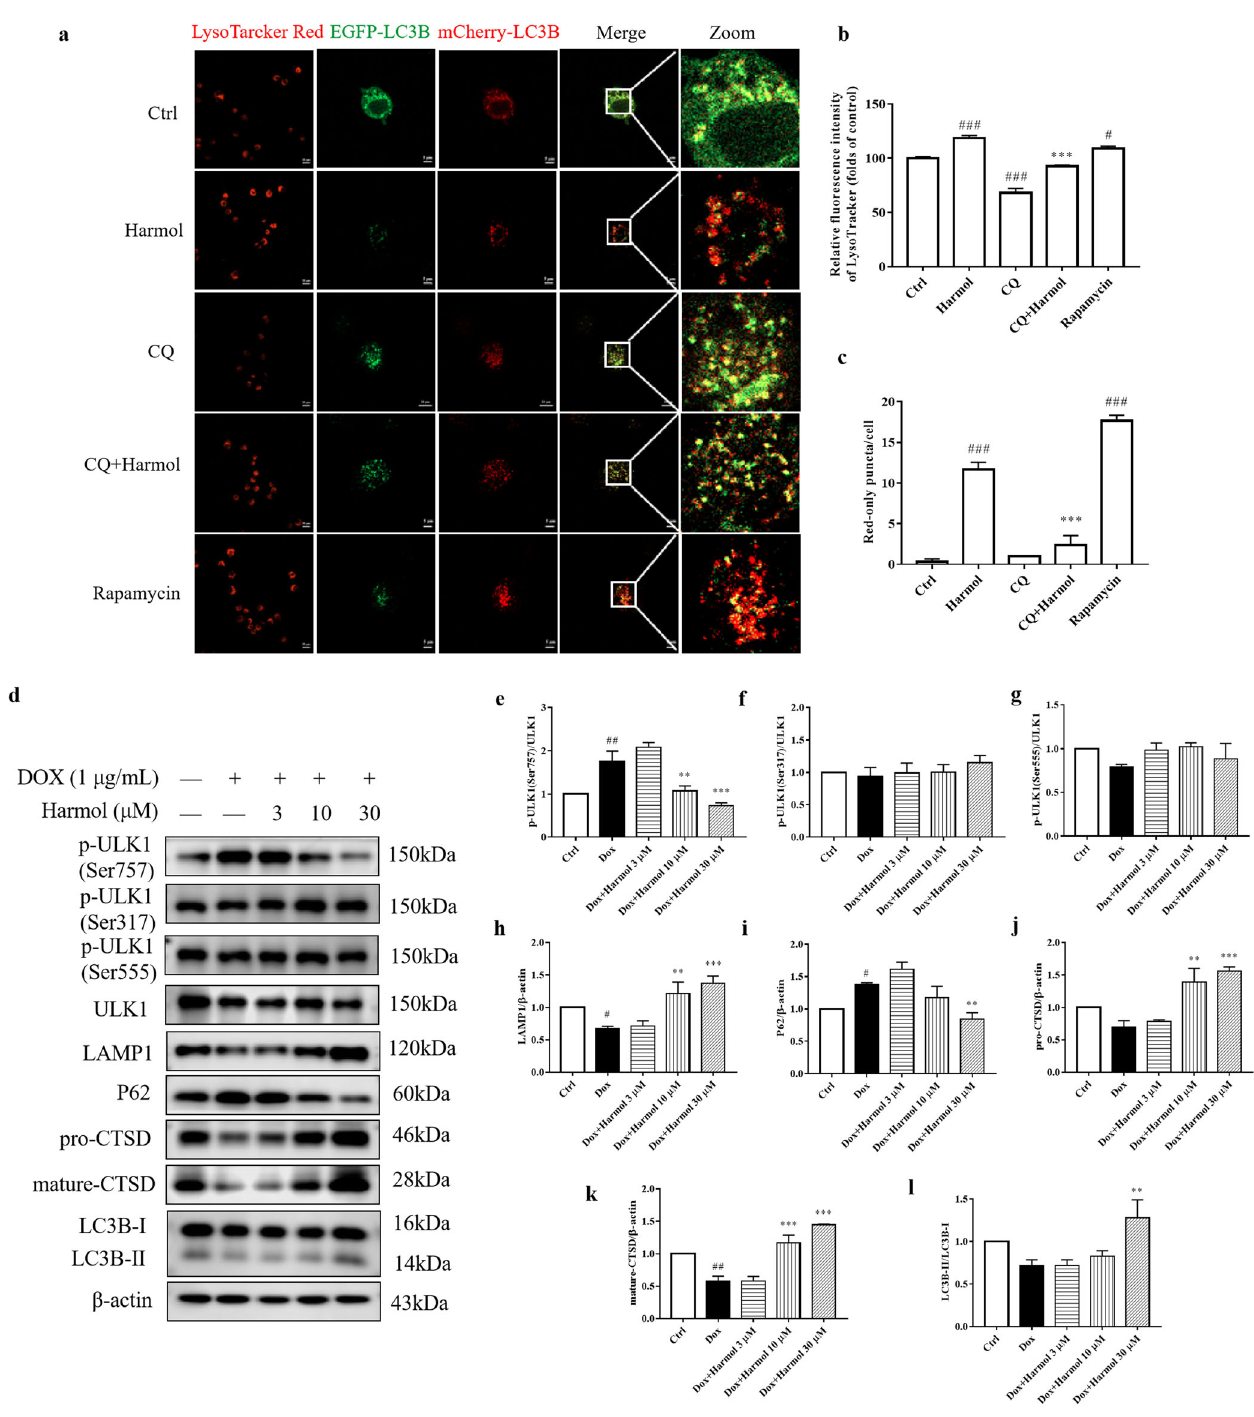
Fig. 3 Harmol promotes autophagy fl ux and lysosomal biogenesis. a N2a cells were treated with the indicated compounds (harmol, 30 µM; CQ, 50 µM; rapamycin, a positive control, 0.25 µM) for 24 h, and then stained with Lyso-Tracker Red (50 nM) for 1 h. In addition, after treated for 2 h, N2a cells were transiently transfected with mCherry-GFP-LC3B adenovirus. Representative images are shown. b Fluorescence intensity was quanti fi ed as the mean ± SEM from three independent experiments. # P < 0.05 and ### P < 0.001 vs. the control (0.1% DMSO). *** P < 0.001 vs. the harmol. c The numbers of red-only puncta per cell were quanti fi ed as the mean ± SEM from three independent experiments. ### P < 0.001 vs. the control (0.1% DMSO). *** P < 0.001 vs. the harmol. d PC12 inducible cells were treated with 1 µg/mL DOX for 24 h, then cells were incubated with 3, 10, and 30 µM harmol for 24 h. The levels of the LC3B-II/LC3B-I, p62, LAMP1, pro-CTSD, mature-CTSD, p-ULK1 (Ser757), p-ULK1 (Ser317), p-ULK1 (Ser555) and ULK1 were determined by western blot. Representative blots are shown. The expression of p-ULK1(Ser757)/ULK1 ( e ), p- ULK1(Ser317)/ULK1 ( f ), p-ULK1(Ser555)/ULK1 ( g ), LAMP1 ( h ), p62 ( i ), pro-CTSD ( j ), mature-CTSD ( k ), and LC3B-II/LC3B-I ( l ) were quanti fi ed as the mean ± SEM from three independent experiments. # P < 0.05 and ## P < 0.01 vs. the control (0.1% DMSO). ** P < 0.01 and *** P < 0.001 vs. the